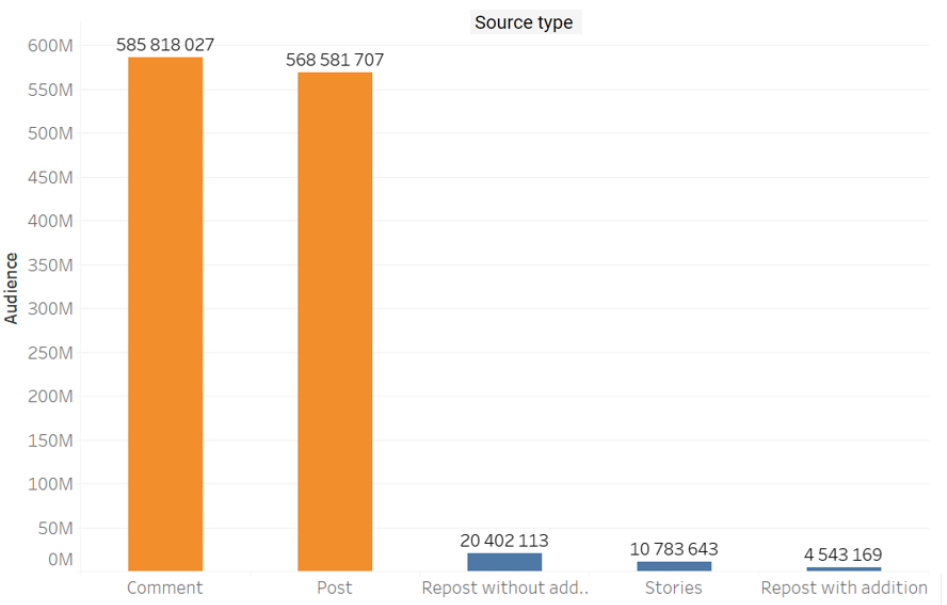
Figure 3. Message types (post, comment, repost with addition, repost without addition).